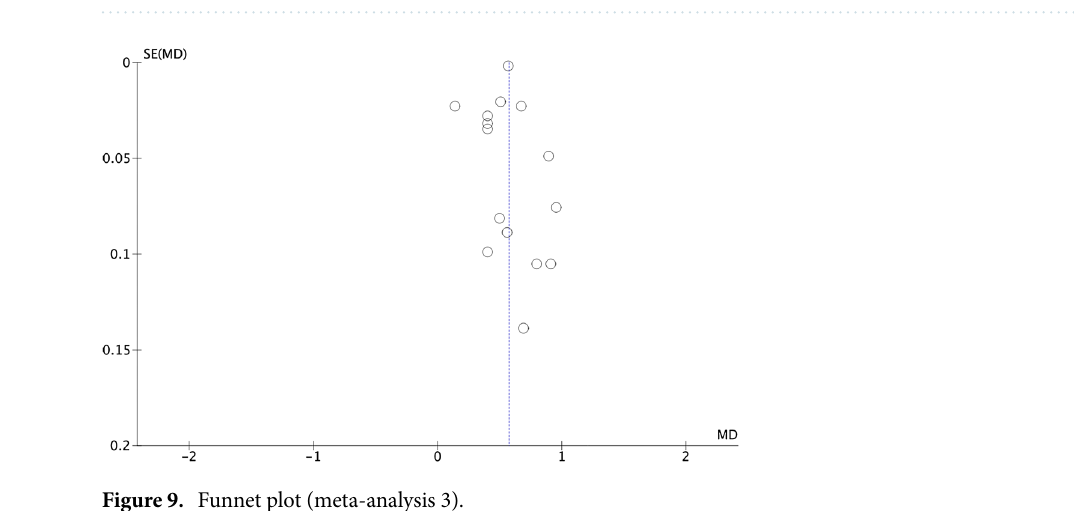
Figure 9. Funnet plot (meta-analysis 3).